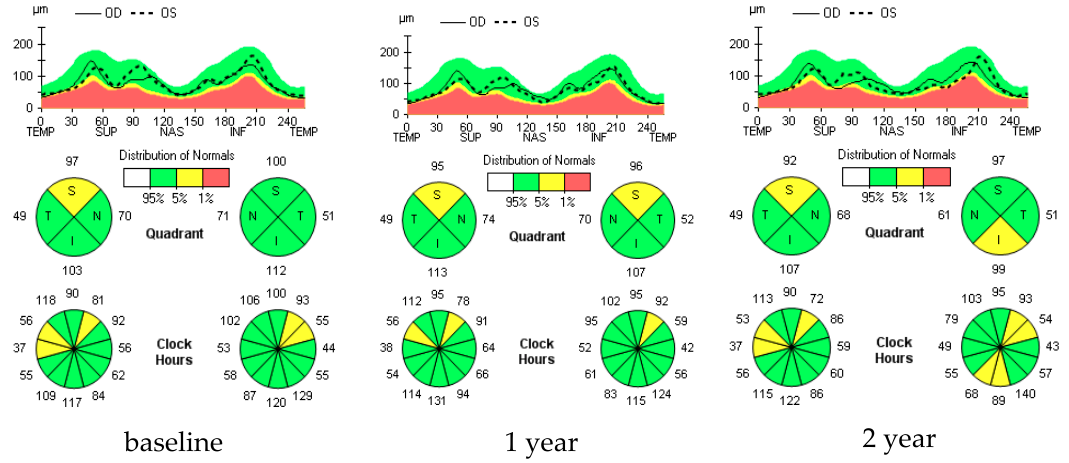
Figure 1. RNFL longitudinal analysis in a selected multiple sclerosis (MS) ON − patient. Figure 1 shows no significant changes in retinal nerve fiber layer thickness (RNFL-T) at various time points in a selected MS ON − patient. In fact, in the colorimetric maps related to the RNFL-T in the peripapillary quadrants (S = superior; N = nasal; I = inferior; T = temporal), performed both 1 year and 2 years after the study baseline, a shift towards warmer colors (e.g., red), which is indicative of a significant thinning of the RNFL, is not observed.